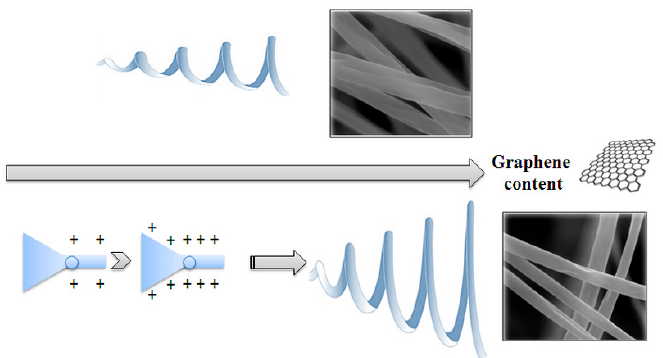
Figure 9. Sketch of the effect of noncovalently functionalised graphene addition on the structure of the electrospun mat.